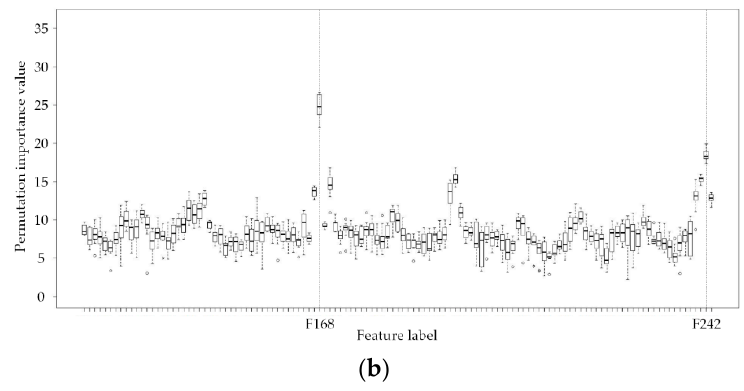
Figure 3. ( a ) Boxplot of the PI value of the first 122 features of 1 ‐ h ‐ ahead prediction; ( b ) boxplot of the PI value of the remaining 121 features of 1 ‐ h ‐ ahead prediction.